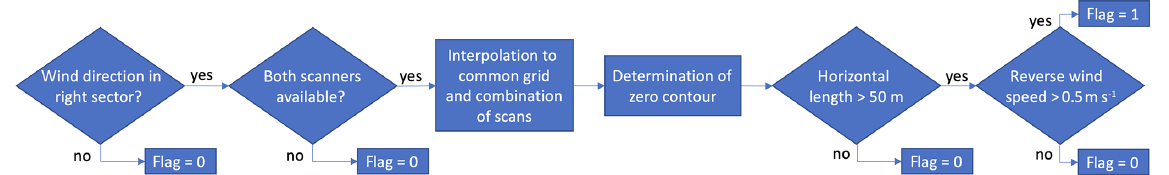
Figure 5. Flow diagram of recirculation zone detection process. Recirculation is detected for periods that are flagged with “1”; no recircula- tion is detected for periods flagged with “0”.